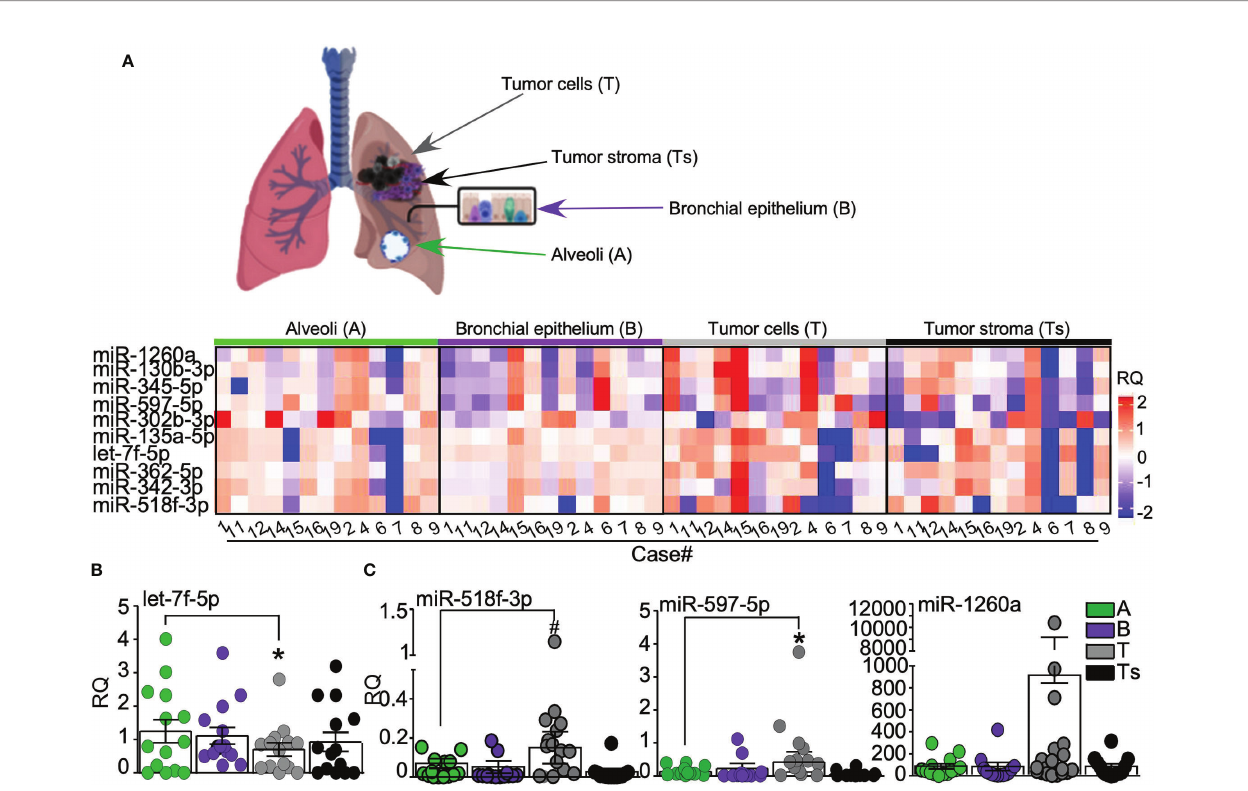
FIGURE 3 | miRNAs validation analysis. (A) Normal bronchial epithelium (B), alveoli (A) as well as lung tumor cells (T) and tumor-surrounding stroma (Ts) were laser- assisted microdissected from surgical specimens of 13 out of the 14 AdCa patients. Heatmap (generated with ComplexHeatmap package) shows the expression levels of the ten selected miRNAs in each case. Upper panel , representative images of the analyzed tissues. (B, C) The expression of the differentially regulated miRNAs in tumor cells is shown, with miRNA let-7f-5p being down regulated (B) , while miR-518f-3p, miR-597-5p, and miR-1260a (C) being up-regulated in lung tumor cells. Each dot is a sample; bars, mean ± SD. *p = 0.04, # p = 0.03 by Mann – Whitney U